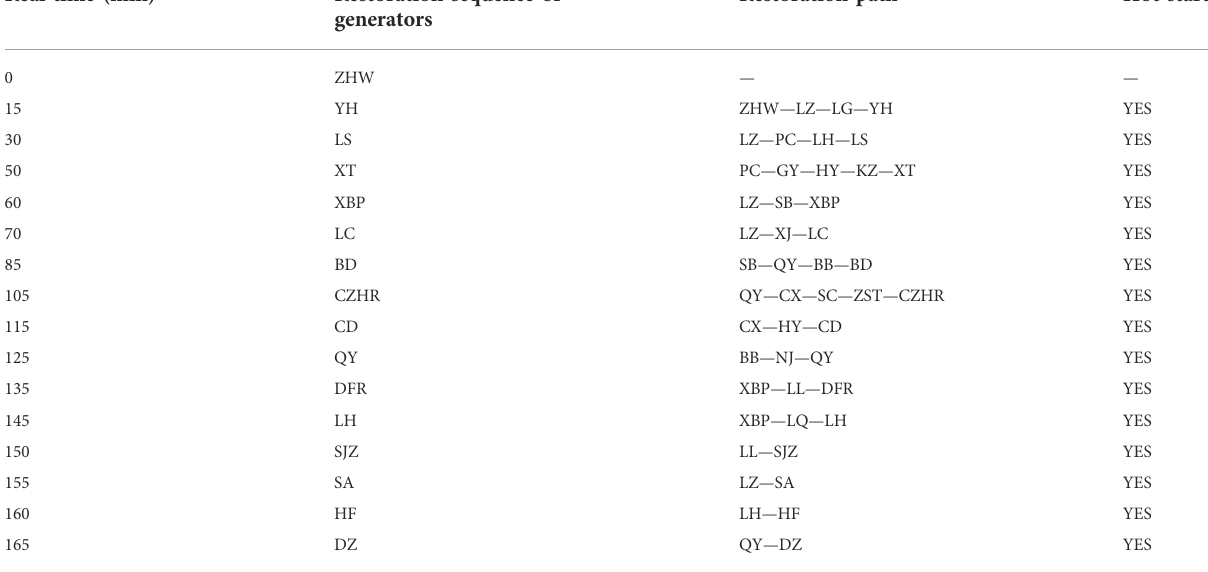
TABLE 5 The restoration schemes of the partial Hebei power system. Real time (min)